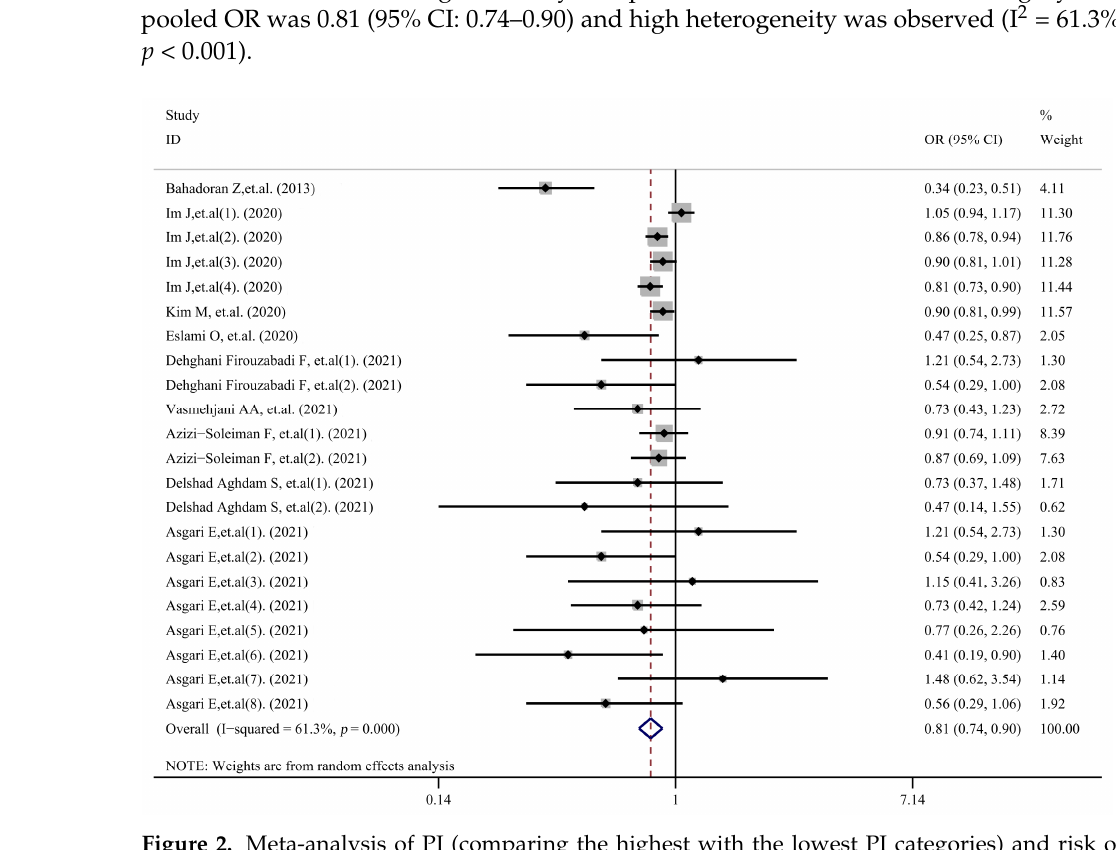
Figure 2. Meta-analysis of PI (comparing the highest with the lowest PI categories) and risk of over- weight/obesity [5,16–20,27–29]